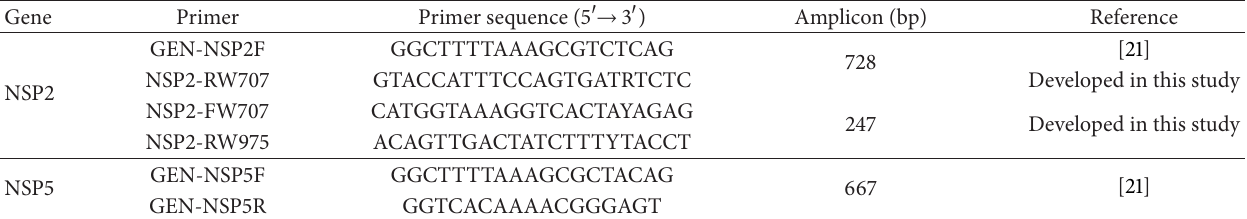
Table 1: Primers designed for amplification and sequencing of the NSP2 and NSP5/6 genes from the samples of this study. bp: base